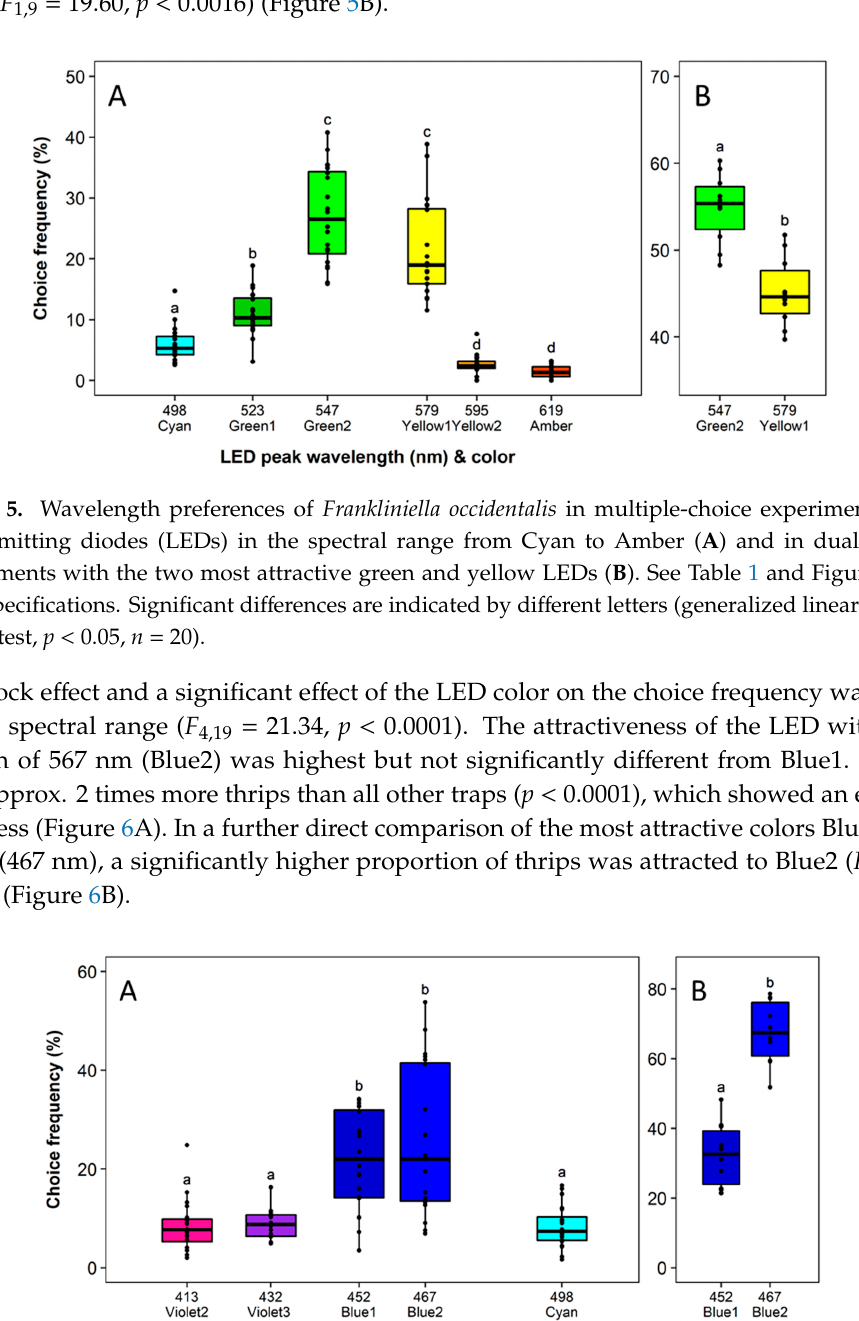
Figure 7. Wavelength preferences of Frankliniella occidentalis in multiple-choice experiment with light- emitting diodes (LEDs) in the ultraviolet and violet spectral range. See Table 1 and Figure 2 for LED specifications. No significant differences were observed (generalized linear model, p < 0.05, n = 20). 3.3. Test for Chromatic Interaction among Most Attractive Wavelengths: UV, Blue, and Green Overall recapture rates in the different experiments ranged from 69.70% to 71.07%. At first, interactions between ultraviolet, blue, and green color were studied. No block effect and a significant effect of the LED color on the choice frequency was observed ( F 5,19 = 25.63, p < 0.0001). Blue2 and Green1 were the most attractive wavelengths, but differed significantly from each other ( p = 0.0008)